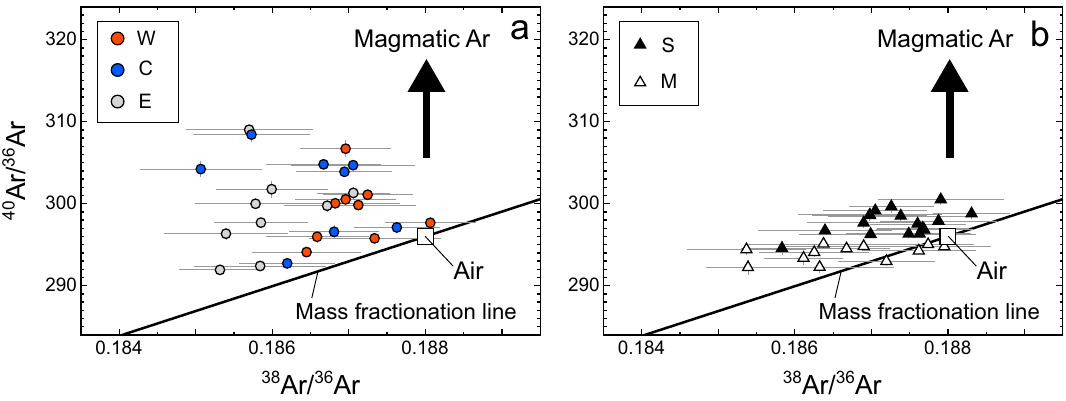
Figure 4. Ar three-isotope diagrams for the fumarolic gas samples collected at the W, C, and E fumaroles in the Kitagawa geothermal area, and the Sesshogawara (S) and Manza (M) fumaroles. The air composition of ( 38 Ar/ 36 Ar, 40 Ar/ 36 Ar) = (0.188, 296) and a mass fractionation line for the atmospheric Ar are also shown 3 .